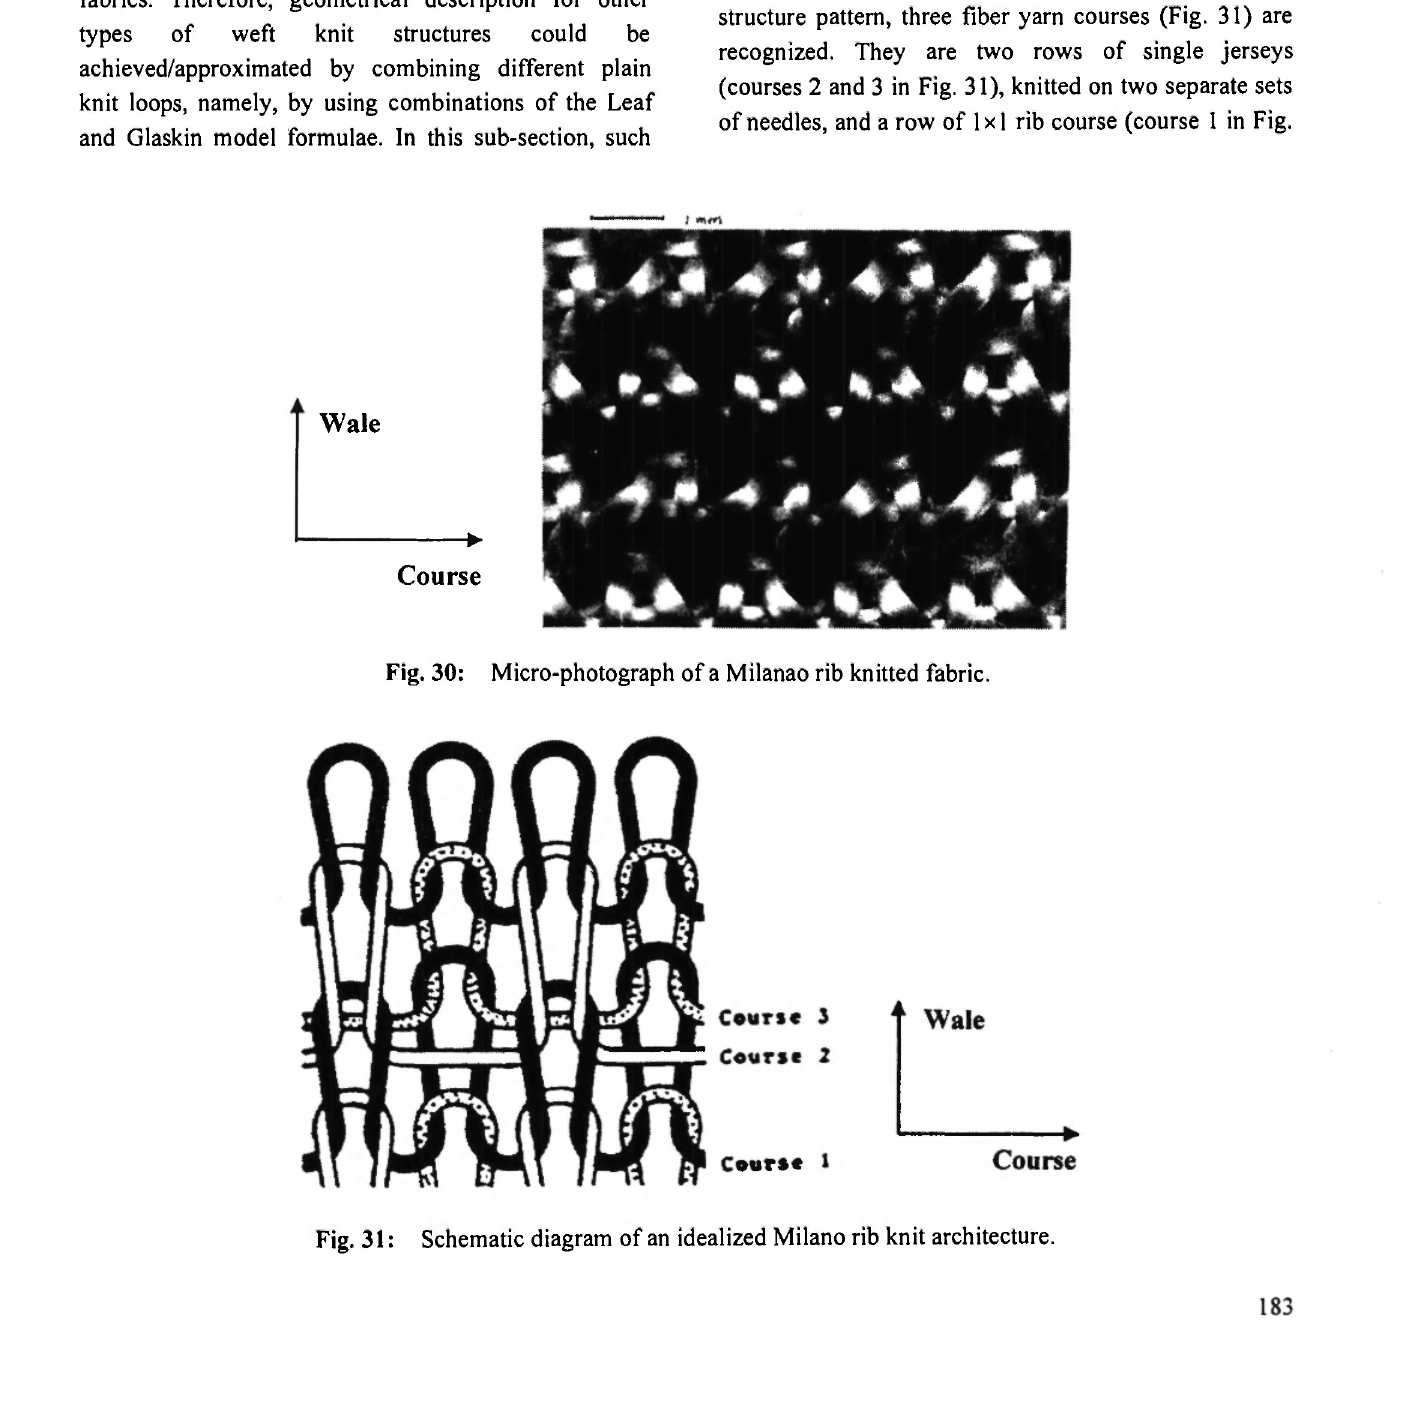
Fig. 31: Schematic diagram of an idealized Milano rib knit